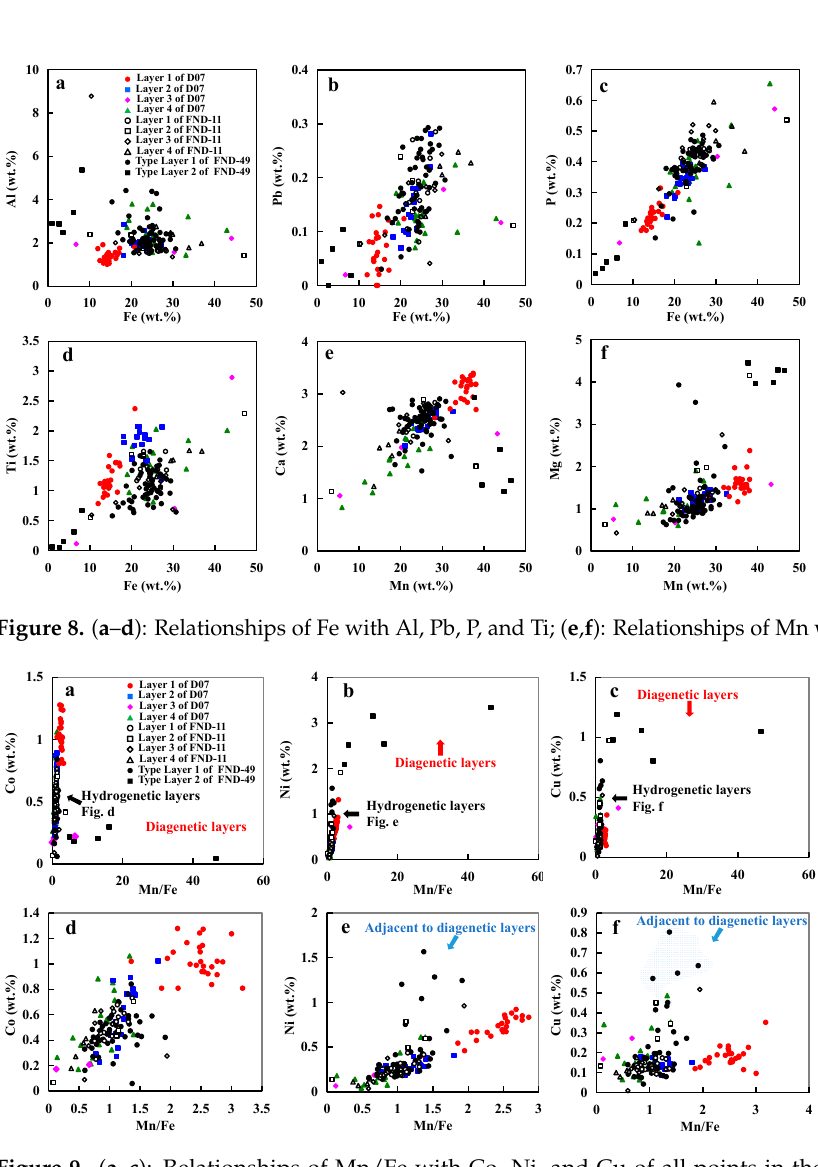
Figure 11. Si-rich layer in the layer 4 of D07.